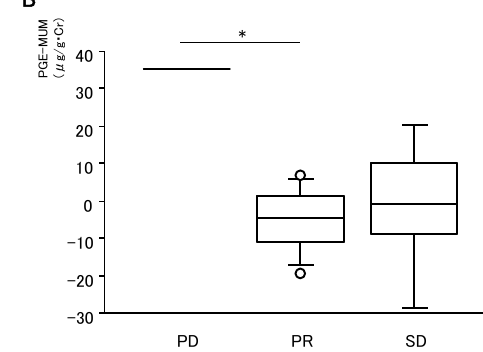
Figure 3. Association of PGE-MUM levels with treatment. Changes in PGE-MUM levels after lung resection are shown in ( A ) ( n = 21). The patients treated with systemic therapies were classified into three groups according to their response to treatment (progressive disease, PD n = 1, partial response, PR n = 8, stable disease, SD n = 5), and the changes in PGE-MUM levels after systemic therapies in each group are shown in ( B ). (* p < 0.05).